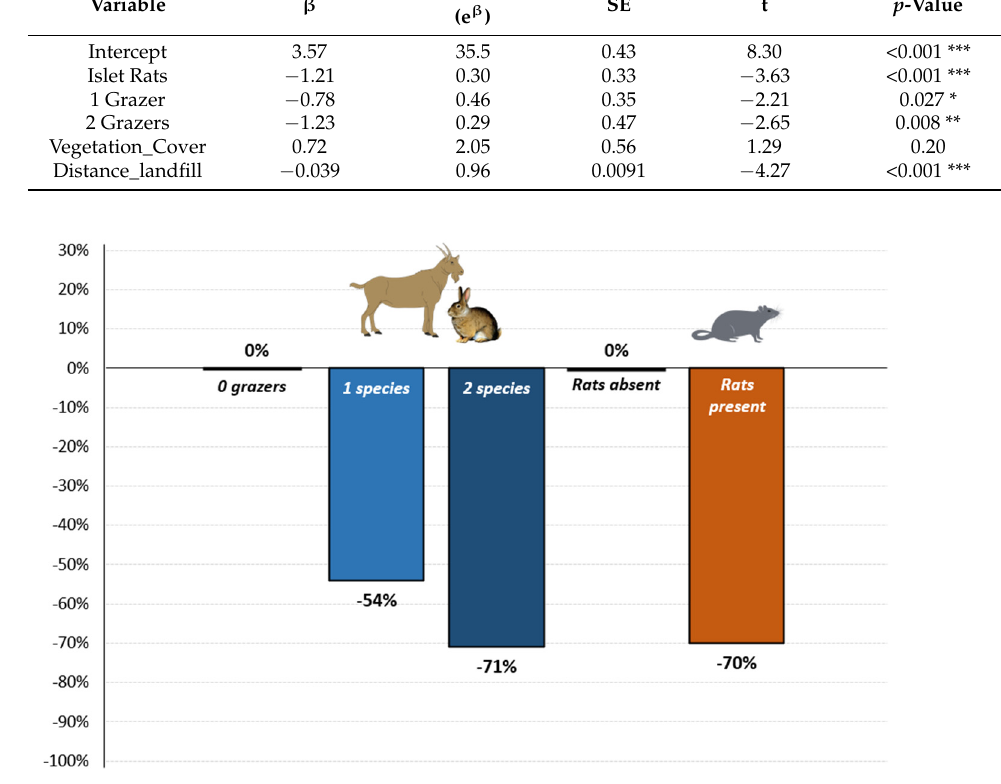
Figure 3. Changes in baseline density of islet breeding colonies based on disturbance type. Baseline